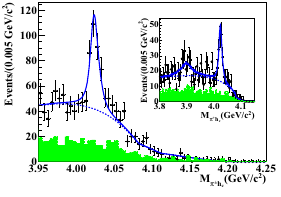
Figure 10. Fit to the π − re- coil mass spectrum from e + e − → ( D ∗ ¯ D ∗ ) ± π ∓ process at 4.26